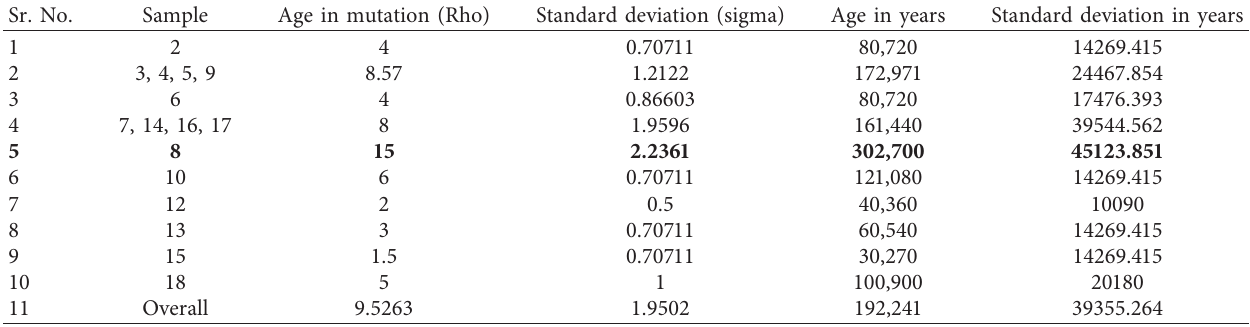
Figure 5: Mismatch frequency of AMEL-Y-null Pakistani male haplotypes. Table 2: Time estimation of mutation from SQ-1 to different variants (SQ-2 to SQ-18) of AMEL-Y-null male Pakistani individuals in Rho and